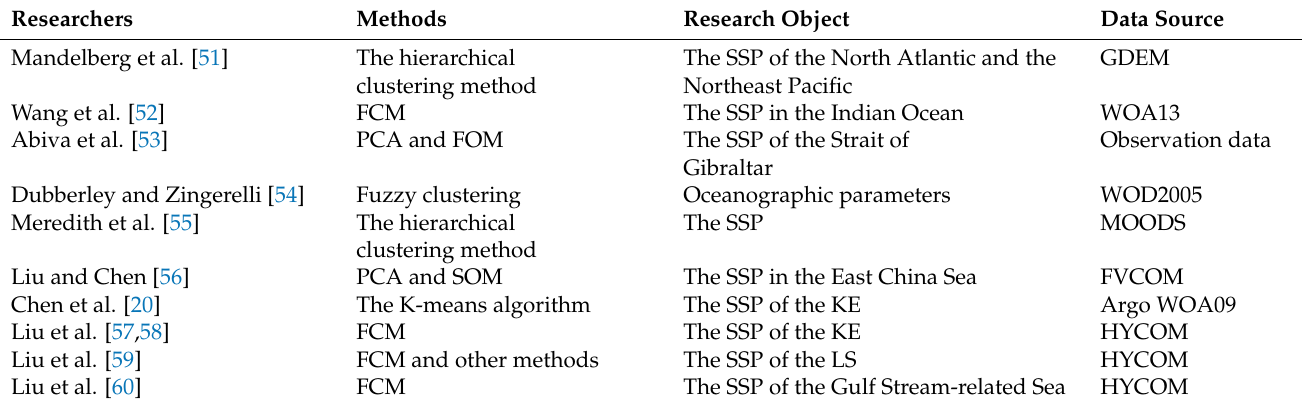
Table 2. Application of clustering methods in the ocean environment and sound speed